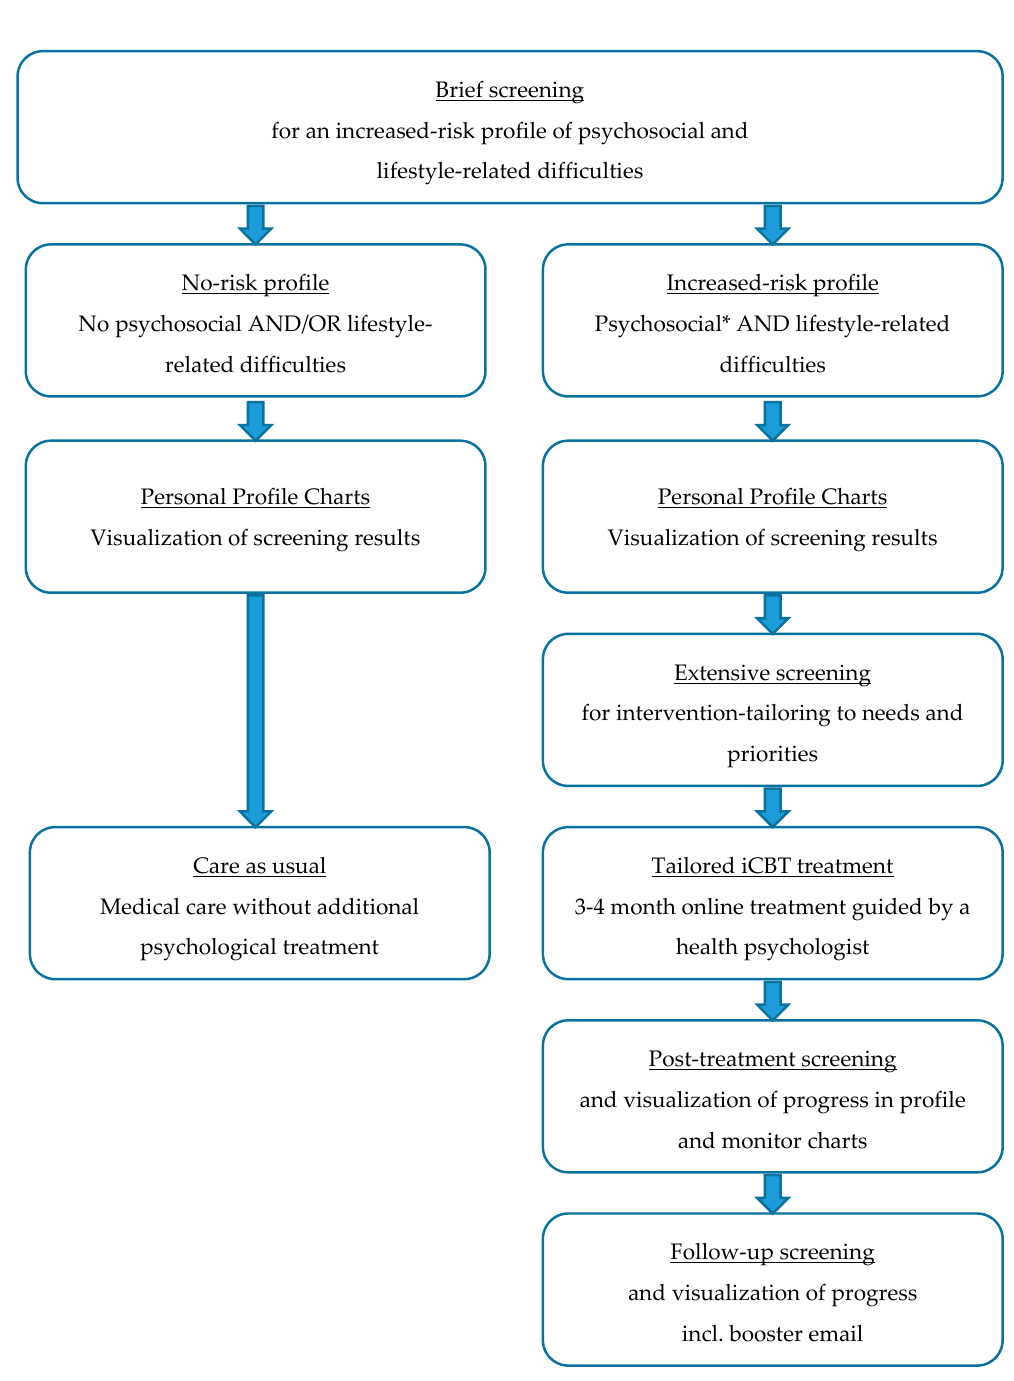
Figure 4. Tailored eHealth care pathway for patients with lifestyle-related chronic diseases. * Patients with severe psychological distress scores are advised to contact their GP for further evaluation and referral to specialized face-to-face mental healthcare.